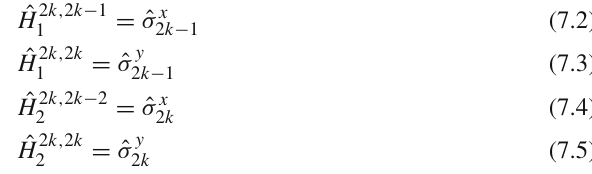
Fig. 2 Interactions network of a dual quantum field